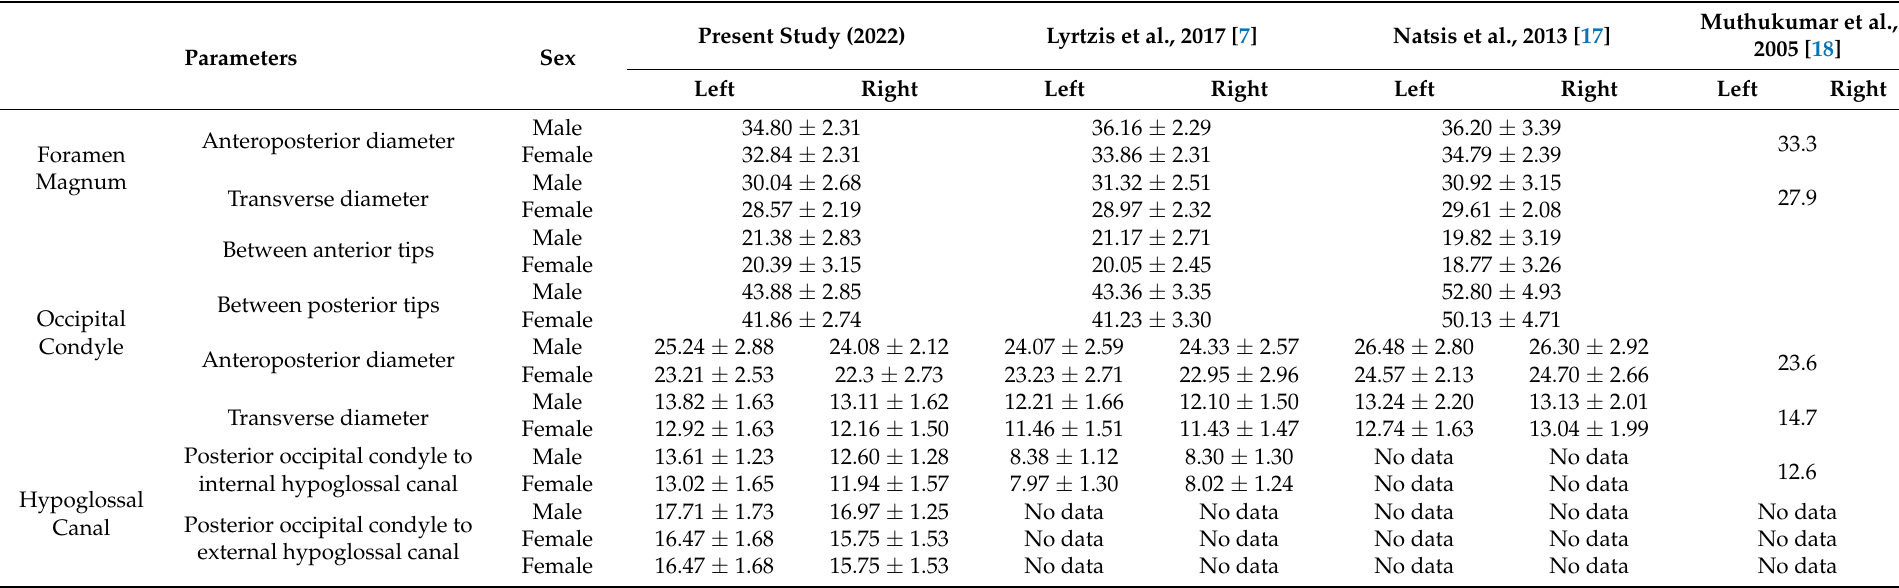
Table 4. Comparison of foramen magnum, occipital condyle and hypoglossal canals among several studies (diameters are expressed in